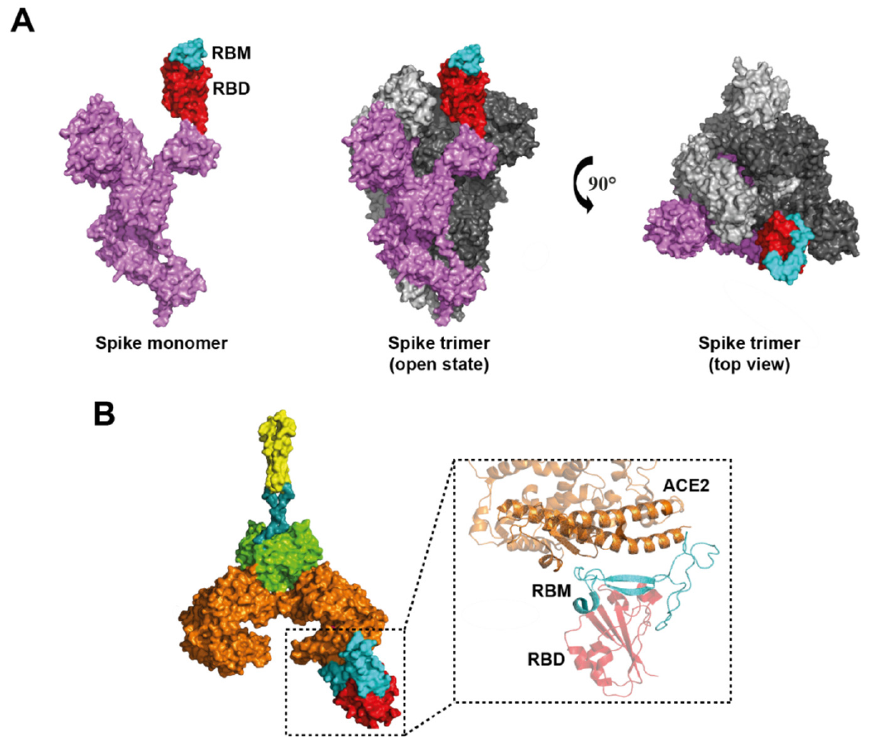
Figure 5. ACE2-RBD (S) complex. ( A ) Structure of a monomer of the S protein in lateral view of the open conformation and Spike trimer; also, the top view (PDB: 6VYB). The receptor binding domain (RBD) and receptor binding motif (RBM) are shown in red and cyan, respectively. ( B ) Structure of the ACE2-RBD complex, in which the amino acids of the RBM and the amino acids of the PD subdomain 1 of ACE2 interact (PDB: 6M17).